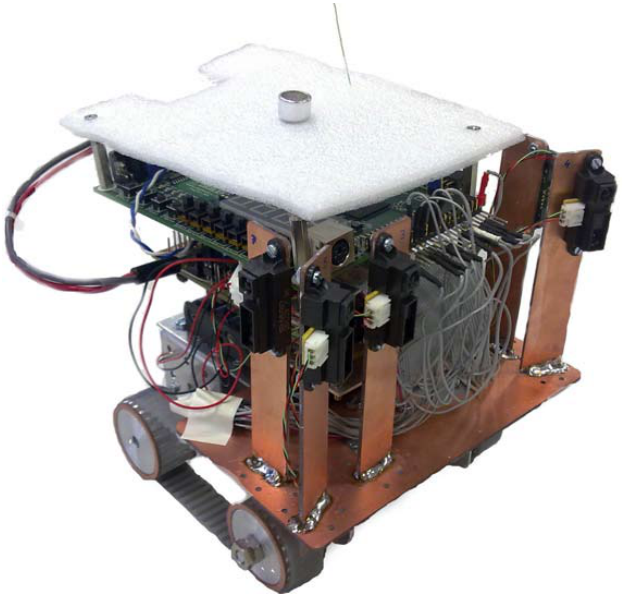
Figure 4. Picture of the mapping